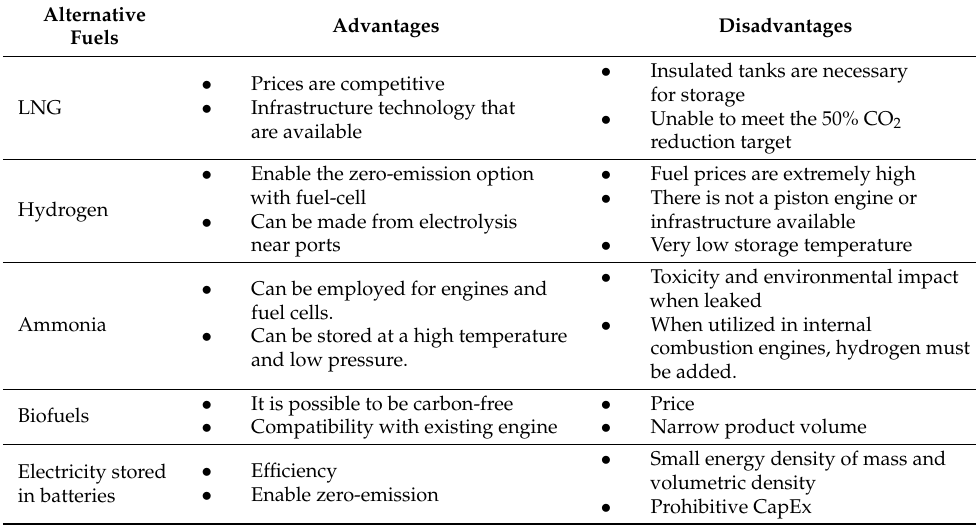
Table 3. Principal benefits and